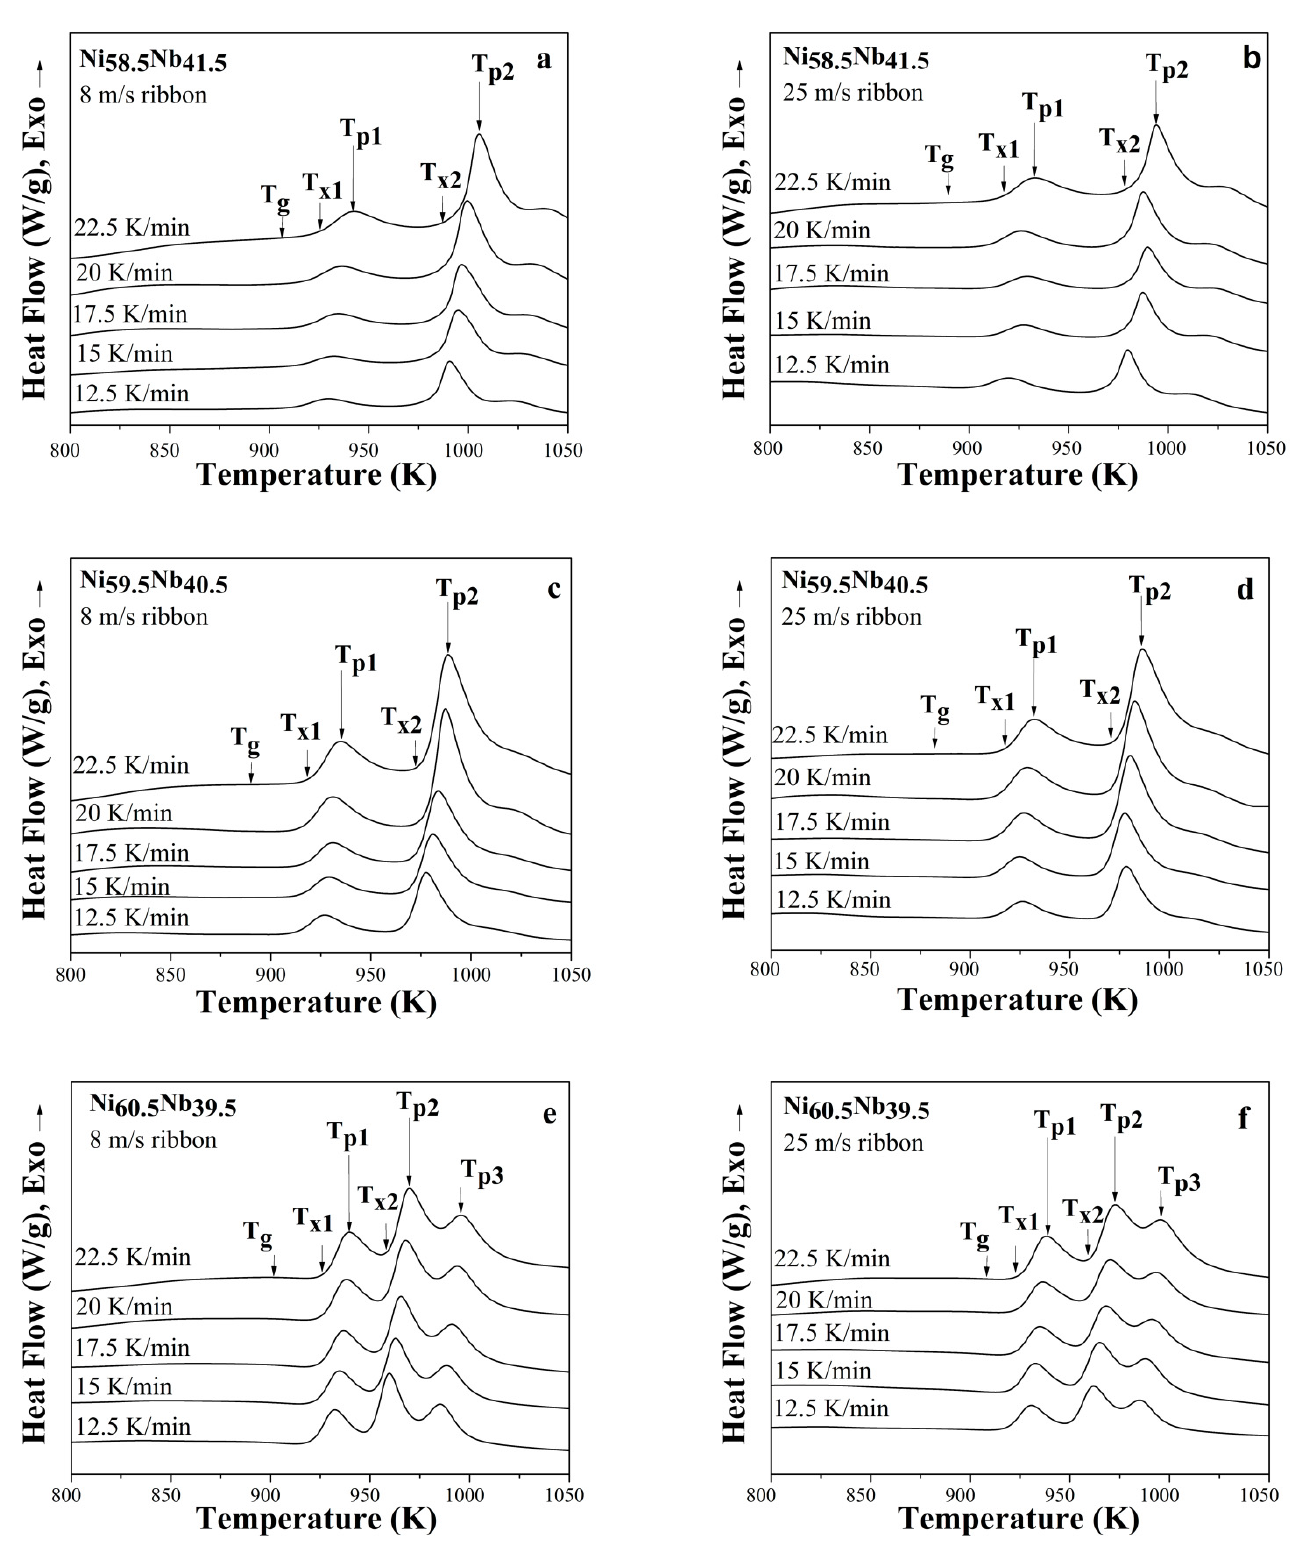
Figure 4. ( a – f ) . DSC curves of Ni 58.5 Nb 41.5 , Ni 59.5 Nb 40.5, and Ni 60.5 Nb 39.5 alloy ribbons cast at 8 and 25 m/s.